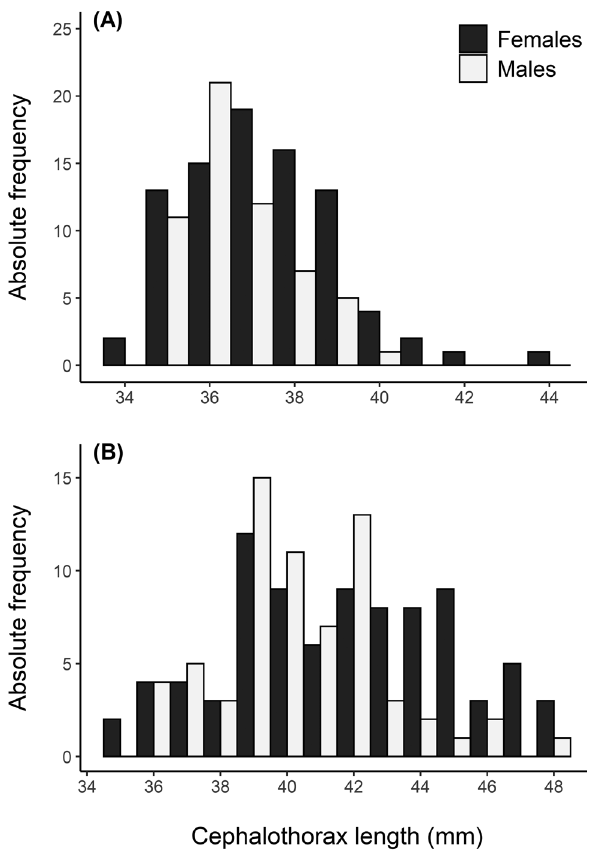
Figure 8. Absolute frequency of cephalothorax length (mm) of Farfantepenaeus brasiliensis ( A ; n = 143) and F. paulensis ( B ; n = 152) captured in Rocha lagoon in April